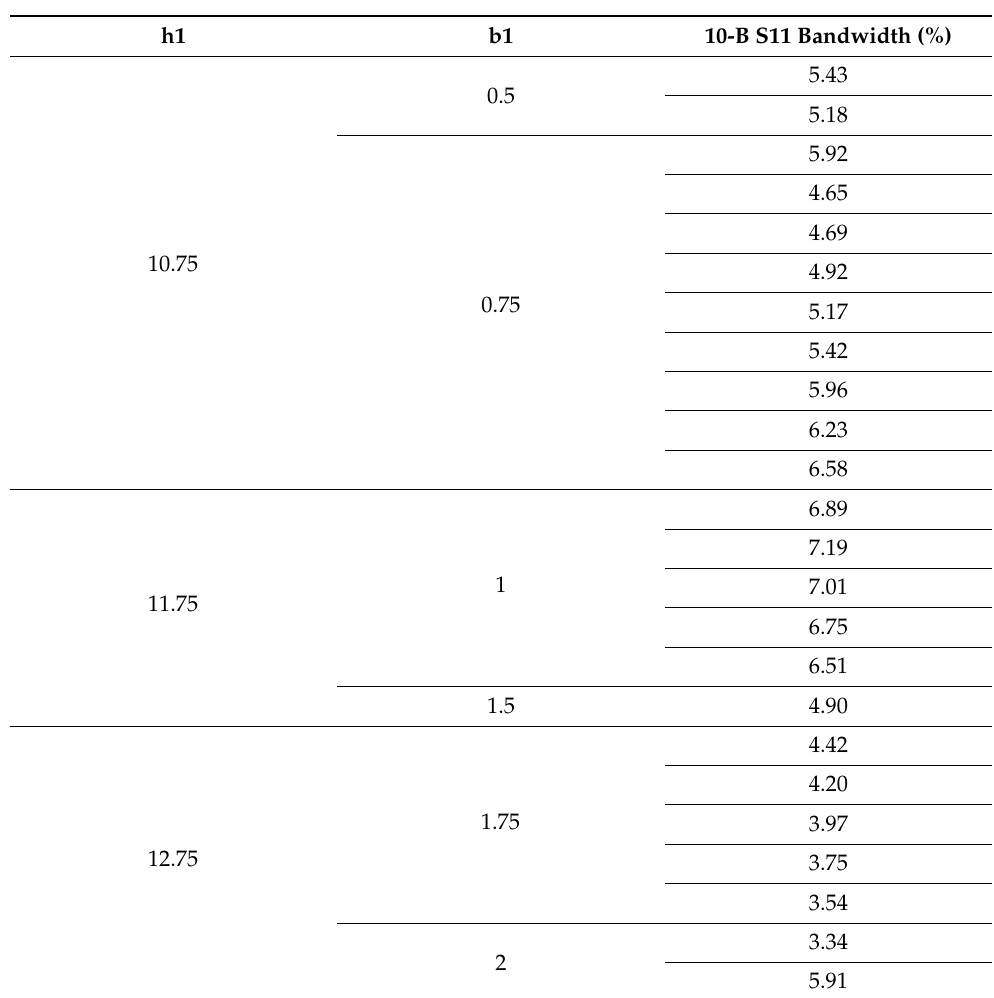
Table 2. Optimization of the feeding strips’ dimensions. (UNIT: